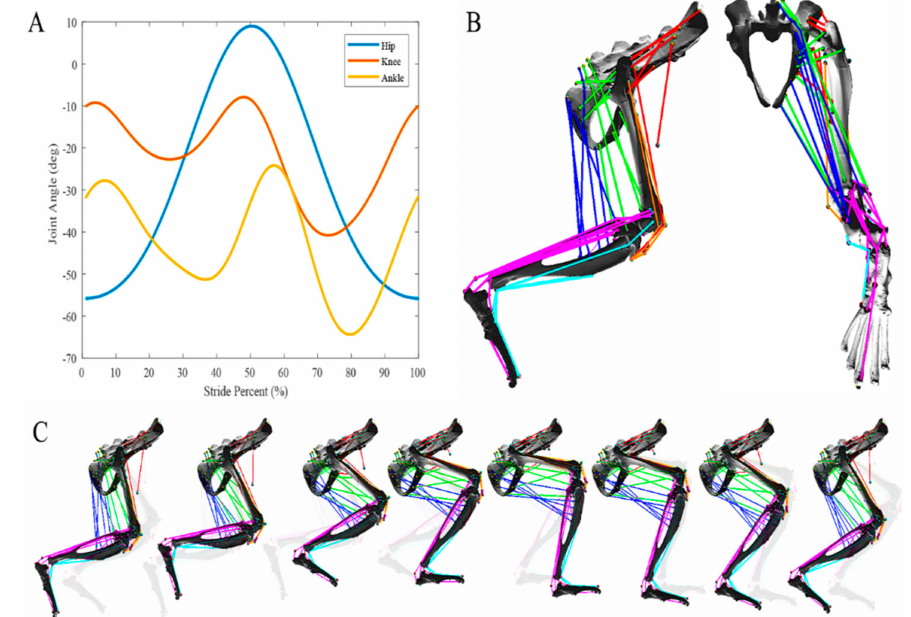
Figure 3. A physiologically relevant walking cycle has been implemented in the AnimatLab simulation. ( A ) Joint angle profiles were developed from walking data [20]. Joint angles are relative to the zero-angle convention established in the AnimatLab simulation, based on the geometric configuration of the joints. ( B ) Complete musculature of the hindlimb from the sagittal and rear coronal view. Coloration added only for visual contrast. ( C ) Complete walking cycle demonstrating the musculature relative to the bone structures during walking. Semitransparent leg configurations included representing the previous leg